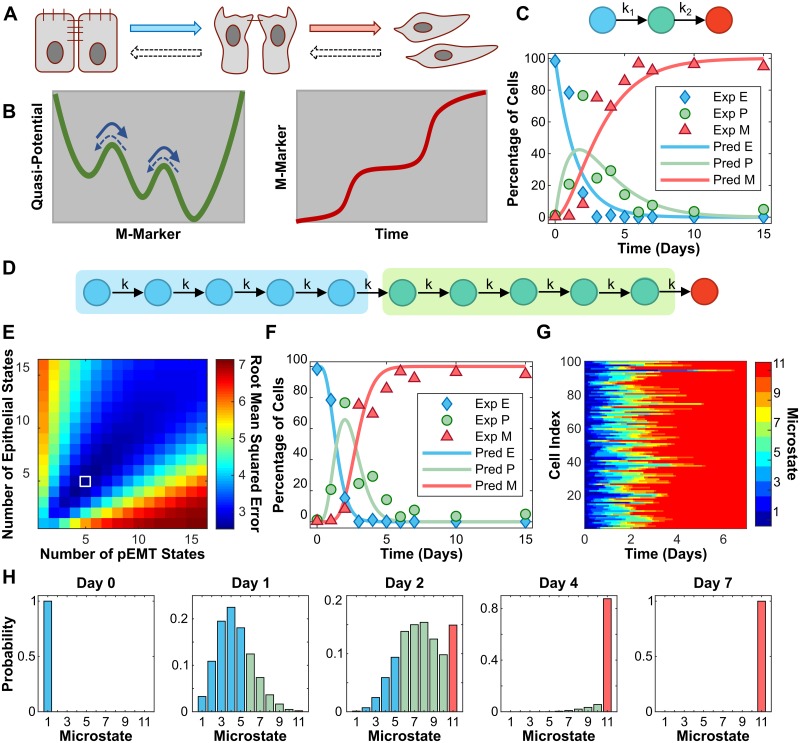
EMT is a non-Markov process.(A) Cell phenotype transitions among epithelial, partial EMT, and mesenchymal states during EMT. (B) Metaphorical three-well landscape in one dimension along the mesenchymal marker (M-Marker) axis shows the cell phenotype transition during EMT. Full arrows show the order of EMT while dashed arrows show reverse process, mesenchymal-to-epithelial transition (MET). (C) Three-state Markov model for EMT (top). Best fit of the three-state model to previous experimental data from Ref. [6] on temporal changes of the percentage of cells in three states during EMT with k1 = 0.6657, k2 = 0.4908, and RMSE = 13.9 (bottom). (D) An extended model with NE epithelial microstates (blue circles) and NP partial EMT microstates (green circles). (E) The fitting score, root mean squared error (RMSE), with the extended model in the space of NE and NP. The best fit is at NE = 5 and NP = 5 (white square, RMSE = 2.55, k = 3.4261). (F) The dynamics of cells in three macrostates during EMT with the best-fitted extended model overlaid with experimental data. (G) Stochastic simulation shows the state transition of 100 simulated cells over time. (H) Probability of cells in each microstate at several time points. 10,000 simulated cells with a stochastic model (see Materials and methods for details) are sampled to calculate the probability.